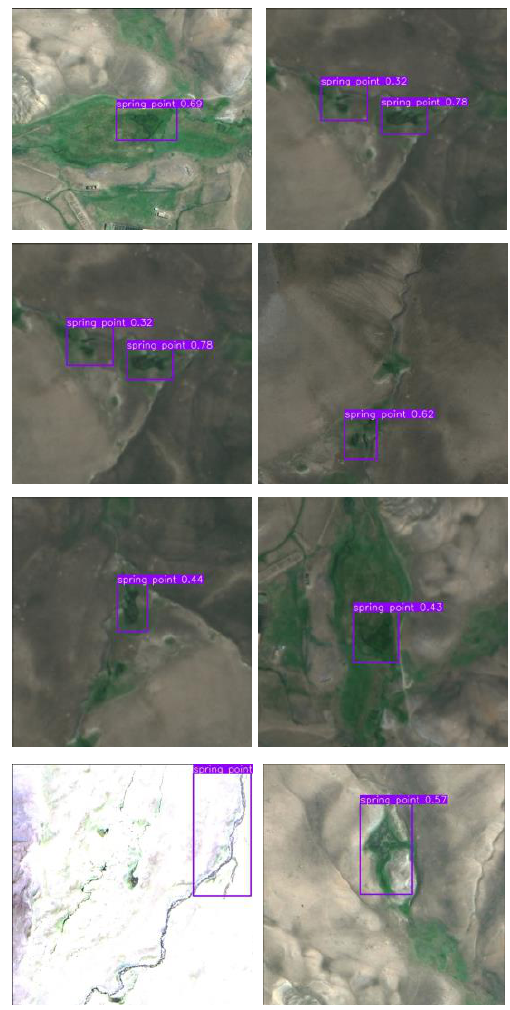
Figure 7. Test result of spring point